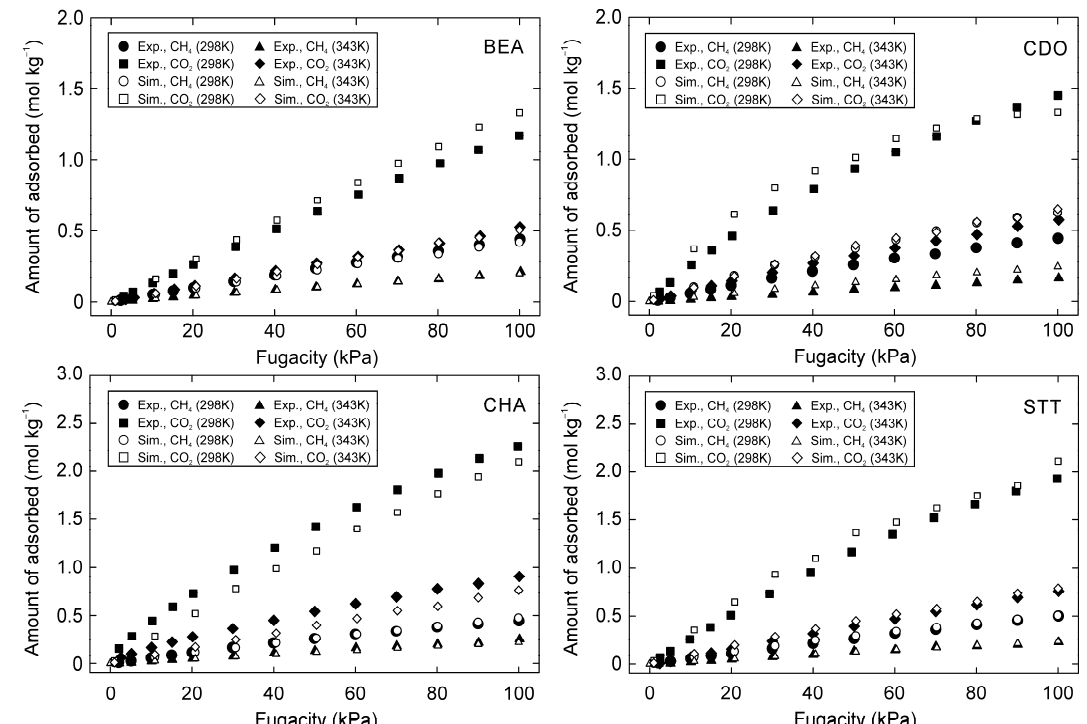
Figure 6. Adsorption isotherms of CH 4 and CO 2 on all-silica (top left) BEA, (top right) CDO, (bottom left) CHA, and (bottom right) STT-type zeolite at 298 K and 343 K.